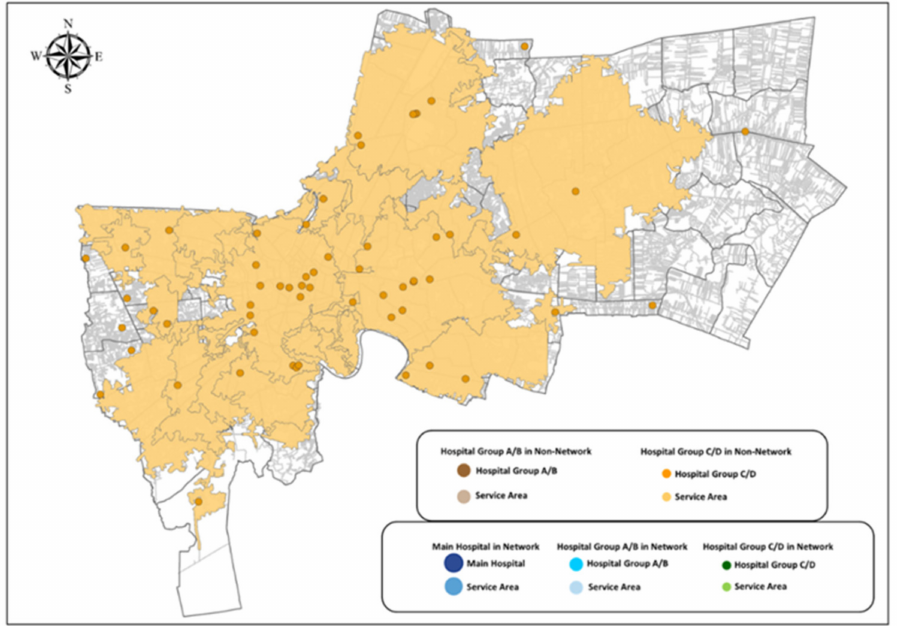
Figure 11. Service area for all non-network